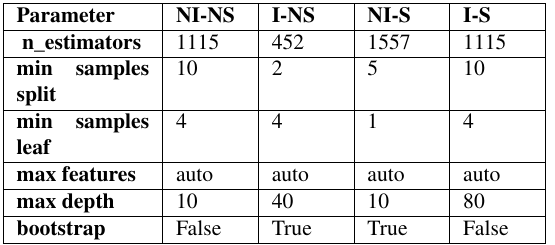
Table 3. Results of the randomized search for optimal values of the hyperparameters of the Random Forest Classifier.NI-NS: No Imputation - No Smoothing, I-NS: With Imputation - No Smoothing, NI-S: No Imputation - With Smoothing, I-S: With Imputation - With Smoothing